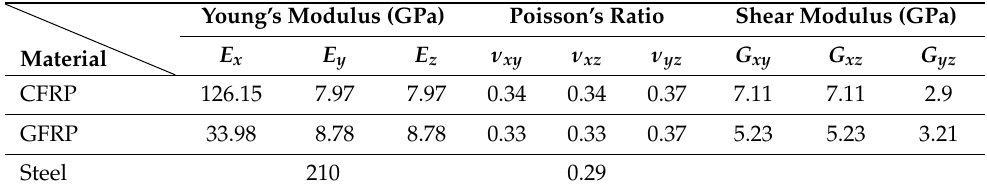
Figure 7. Final shape of the fabricated samples after removal from the tool and subsequent cutting depicted in ( a ) side view and ( b ) top view (points marked A and B indicate the two positions considered for determination of residual stresses to be discussed in the remainder of present work). Table 1. Relevant mechanical properties of the respective parts of the hybrid